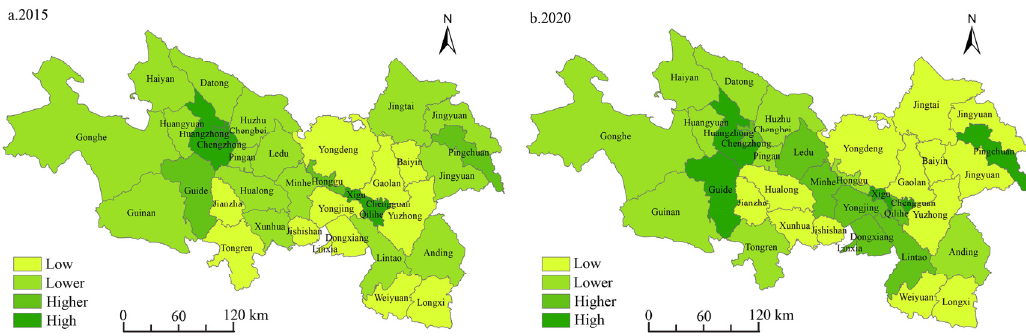
Figure 2. Spatial pattern of the ULGUE of Lanzhou-Xining urban agglomeration in the Yellow River Basin.